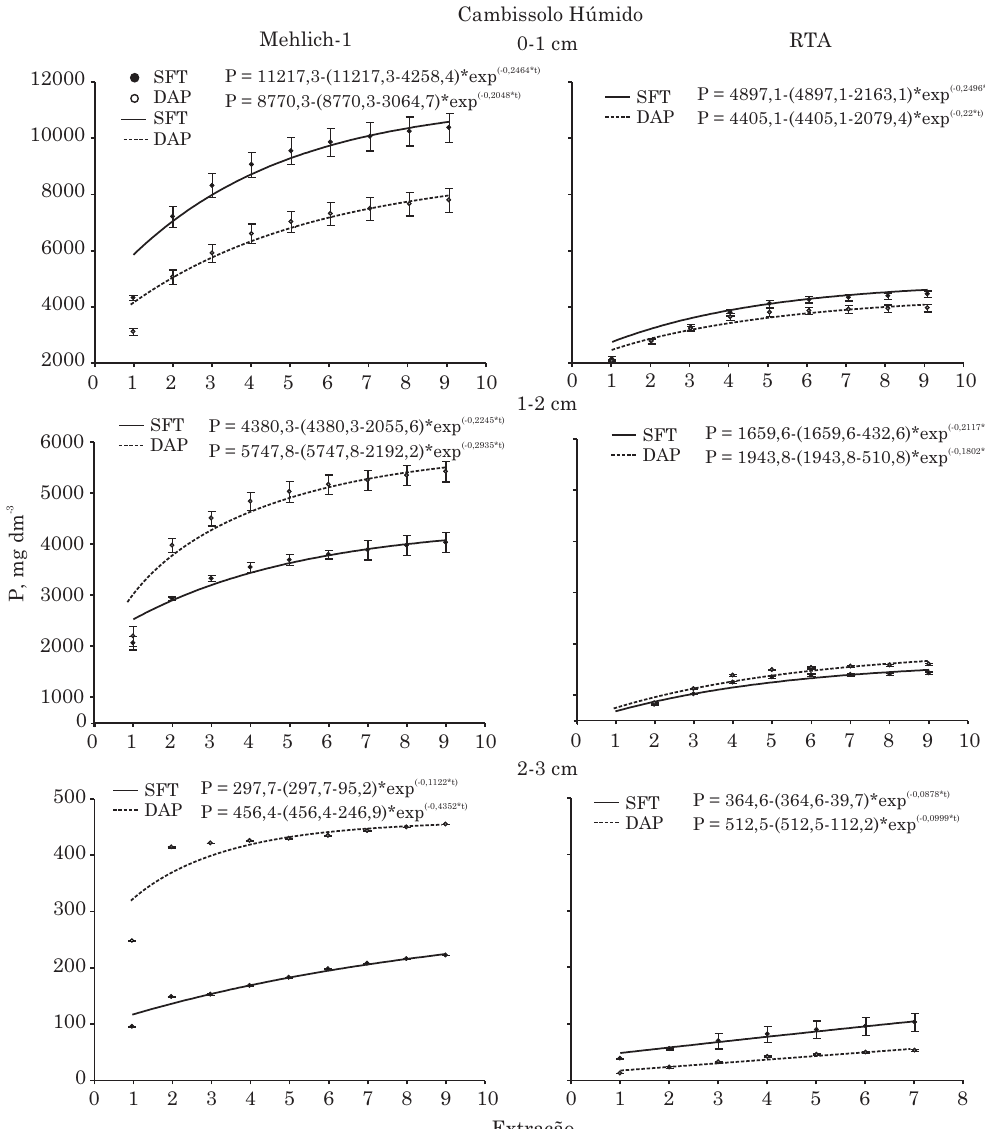
Figura 2. Dessorção acumulada de fósforo ao longo de nove extrações sucessivas em diversas camadas distante do local de aplicação dos fertilizantes em um Cambissolo Húmico, quantificada pelos métodos de Mehlich-1 e da resina trocadora de ânion (RTA). SFT: superfosfato triplo; e DAP: diamônio